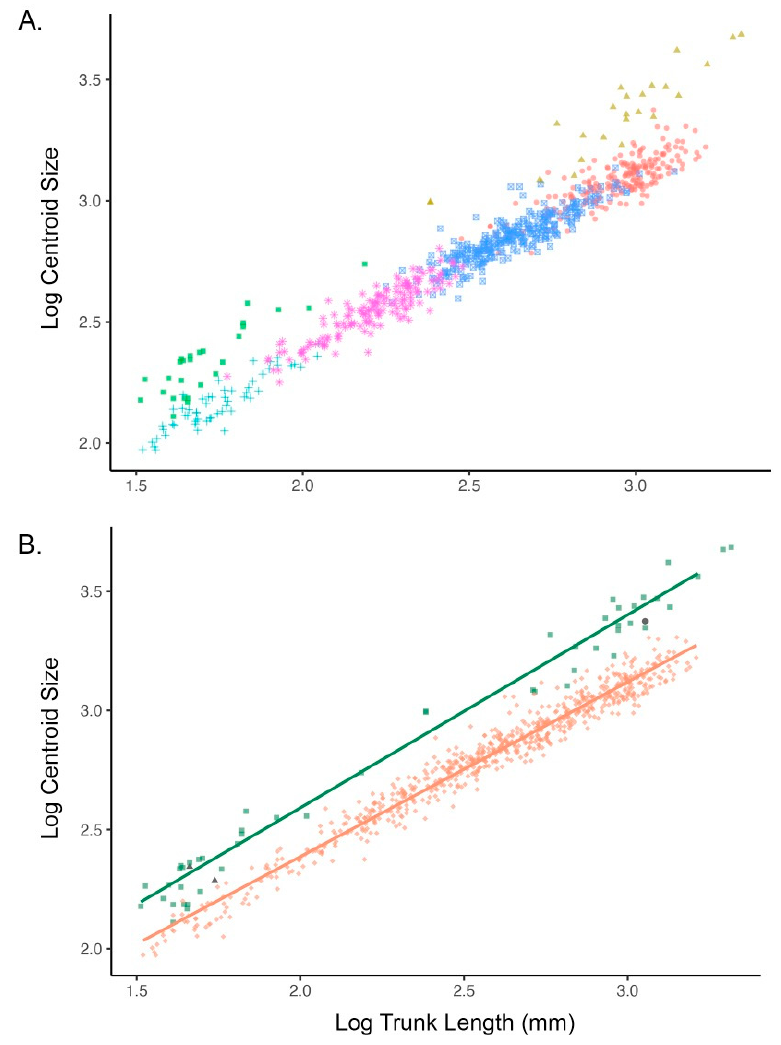
Figure 2. Allometric plots showing relationship between log centroid size (CS) and log trunk length (TL) for all individuals included in the study ( n = 773). ( A ) Individuals grouped by mclust; green squares and golden triangles represent Eurycea waterlooensis clusters; ( B ) Specimens grouped by species, indicating two E. waterlooensis specimens previously misidentified as E. sosorum (grey triangles) and the single specimen of E. waterlooensis assigned to E. sosorum by mclust (grey circle). Teal symbols represent E. waterlooensis and salmon symbols represent E. sosorum .